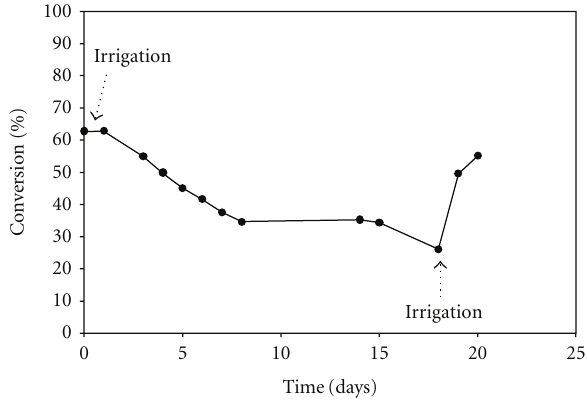
Figure 6: Conversion of CH 4 as a function of time at a GFR of 5.5L/min and a CH 4 inlet concentration of 2.3g/m 3